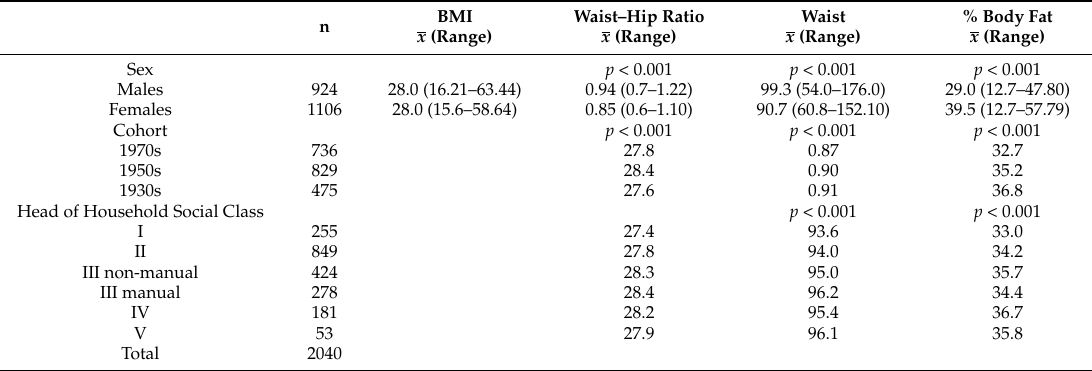
Table 1. Basic descriptives. BMI: body mass index.